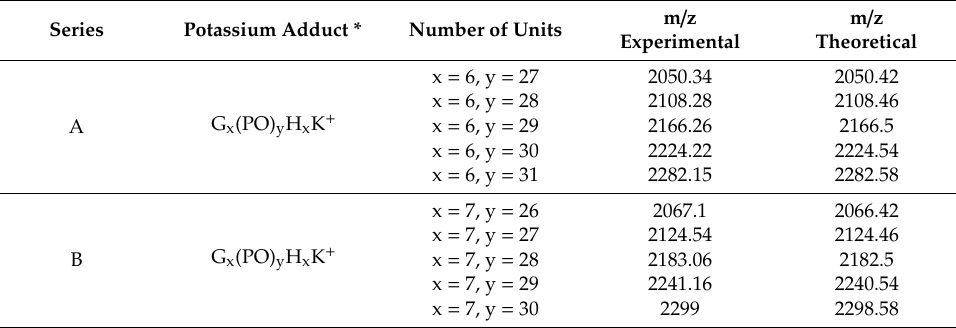
Figure 5. The MALDI-ToF mass analysis of AP1 Polymer. The structures of the utilized polymers are shown on the Figures 6–9. Their characterization was the subject of the separate paper, “Synthesis and spectral analysis of hyperbranched poly(ethers) containing carbazole or hydrazone groups” [40]. For each sample geometric simulation was performed using Cambridgesoft ChemOffice software. For AP I (Figure 6), S XVI (Figure 7), SXVII (Figure 8), S XVIII (Figure 9) the simulation was performed for the structure with one side–arm to present clearly location of the side chain. Figure 6. Structures of studied polymer—AP I Mn = 5300, D = 1.40.